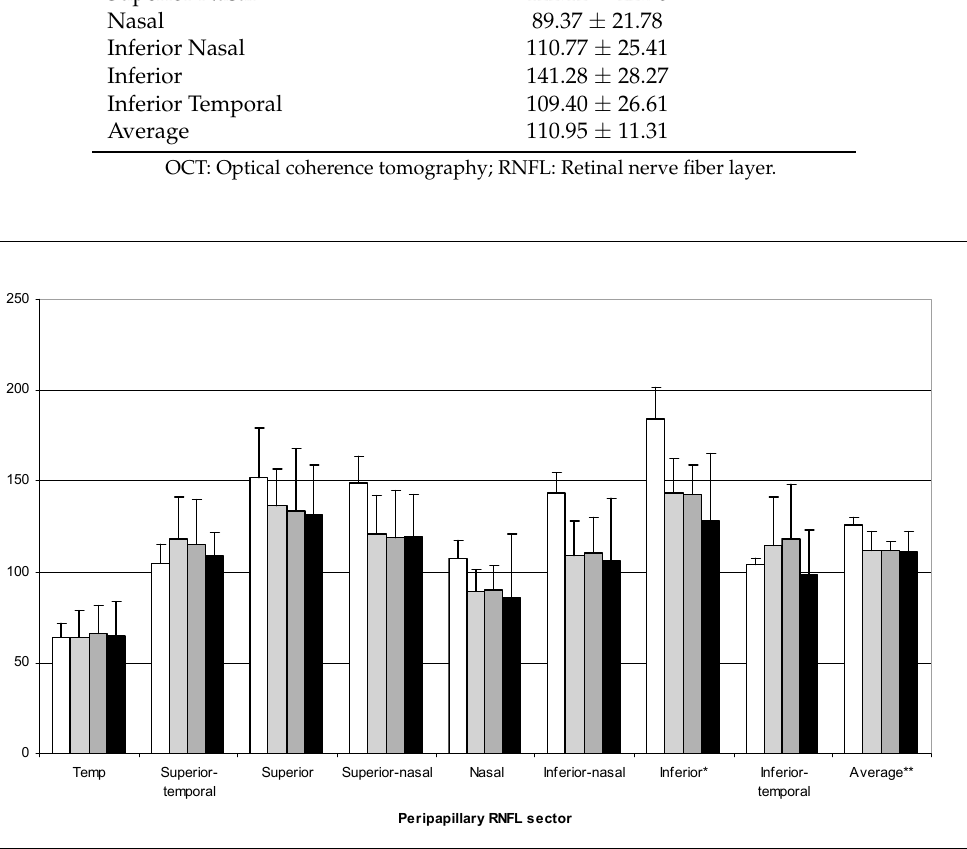
Figure 1. RNFL measurements of different peripapillary sectors according to AMD stages (white bar: stage 2, light gray bar: stage 3, dark gray bar: stage 4, black bar: stage 5). Data are presented as mean ± standard error of the mean. (OCT: Optical coherence tomography; AMD: Age-related macular degeneration; RNFL: Retinal nerve fiber layer. * p = 0.015; ** p = 0.049).